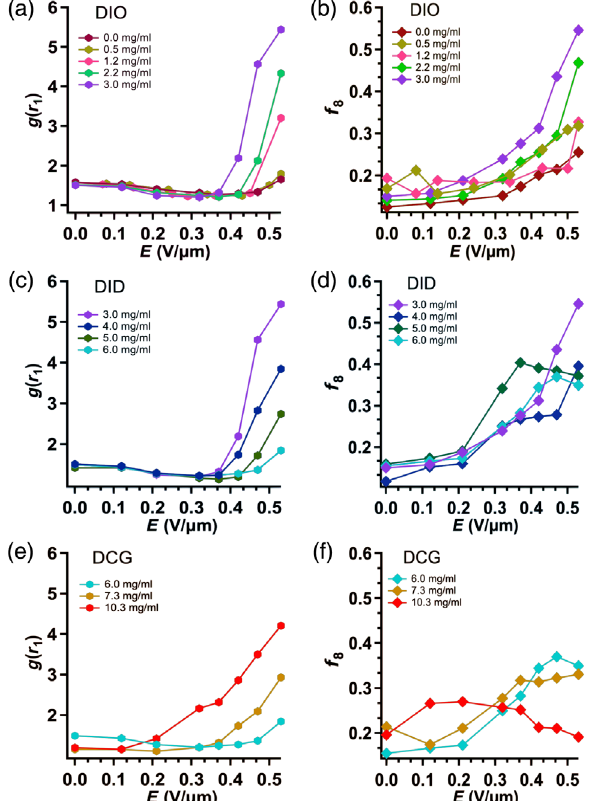
FIG. 3. Quantitative analysis of the ordering, disordering, and gel regimes. The height of the first peak of radial distribution function g ð r 1 Þ and fraction of particles with high ¯ ψ 8 ( f 8 ) varies ¼ 0 . 53 V = μ m, where with the field strength. (a),(b) At E max ¼ 0 to phase transition happens, g ð r 1 Þ increases from c p 3 mg = ml due to increase in the ordering of the structure and local orientational order f 8 increases as well. (c),(d) Both g ð r 1 Þ and f 8 decrease in the second regime (DID). (e),(f) g ð r 1 Þ again ¼ 6 to 10 . 3 mg = ml, increases in the third regime (DCG) from c p whereas f 8 further decreases in this regime due to the formation of large disordered